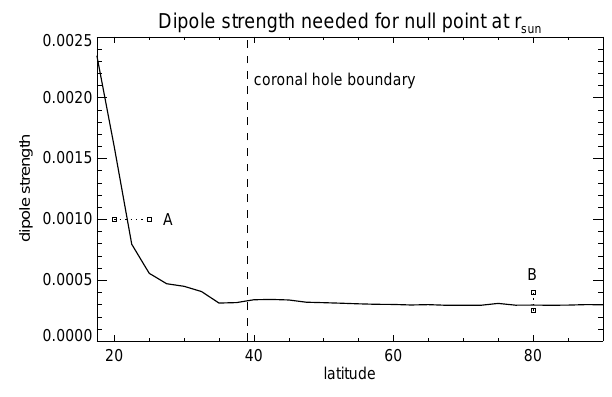
Fig. 6. Dipole strength needed to produce a magnetic null at the solar surface as a function of solar latitude. The squares connected by a dotted line indicate the two situations described in Sects.